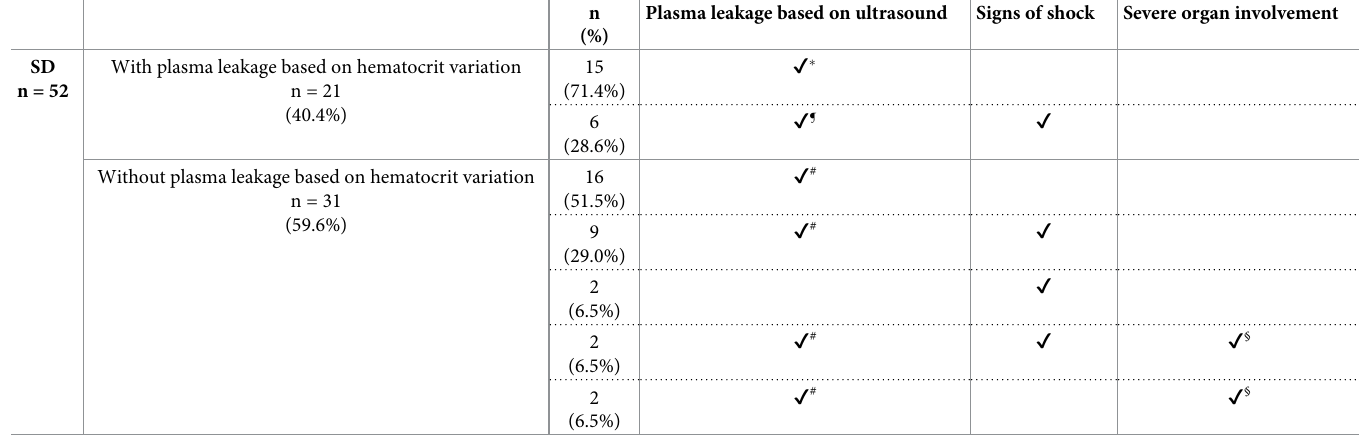
Table 6. Description of biological and clinical manifestations presented by laboratory-confirmed dengue patients classified as SD (n = 52) adapted from the WHO 2009 case definition.